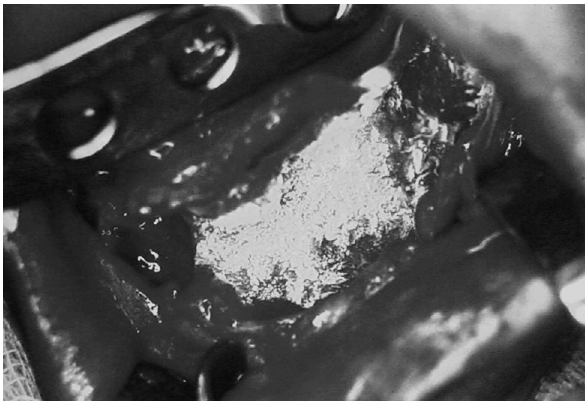
Figure 6 - Frozen bone after liquid nitrogen